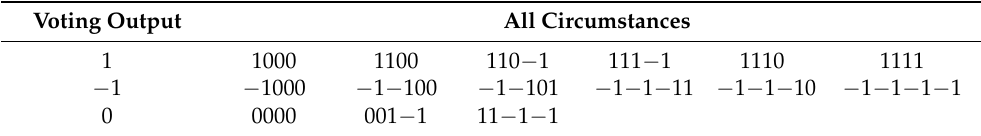
Table 2. Input and output of